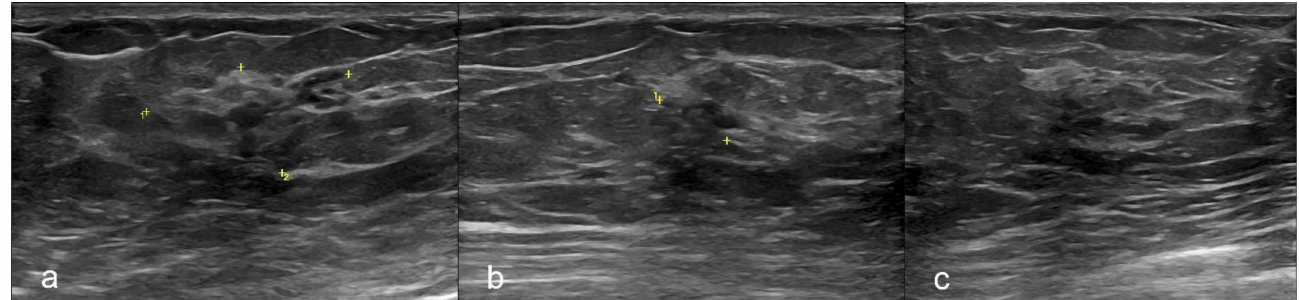
Figure 2. Ultrasonography. Breast ultrasound (US) in different projections showing an ill-defined, hypoechoic area of acoustic shadowing with peripheral anechoic lacunae at the union of outer quadrants of the left breast. ( a ) The yellow mark showed the whole area. ( b ) The yellow mark showed the small area of architectural distortion with acoustic shadowing. ( c ) US-guided Fine-Needle Aspiration Cytology (FNAC) of the lesion.